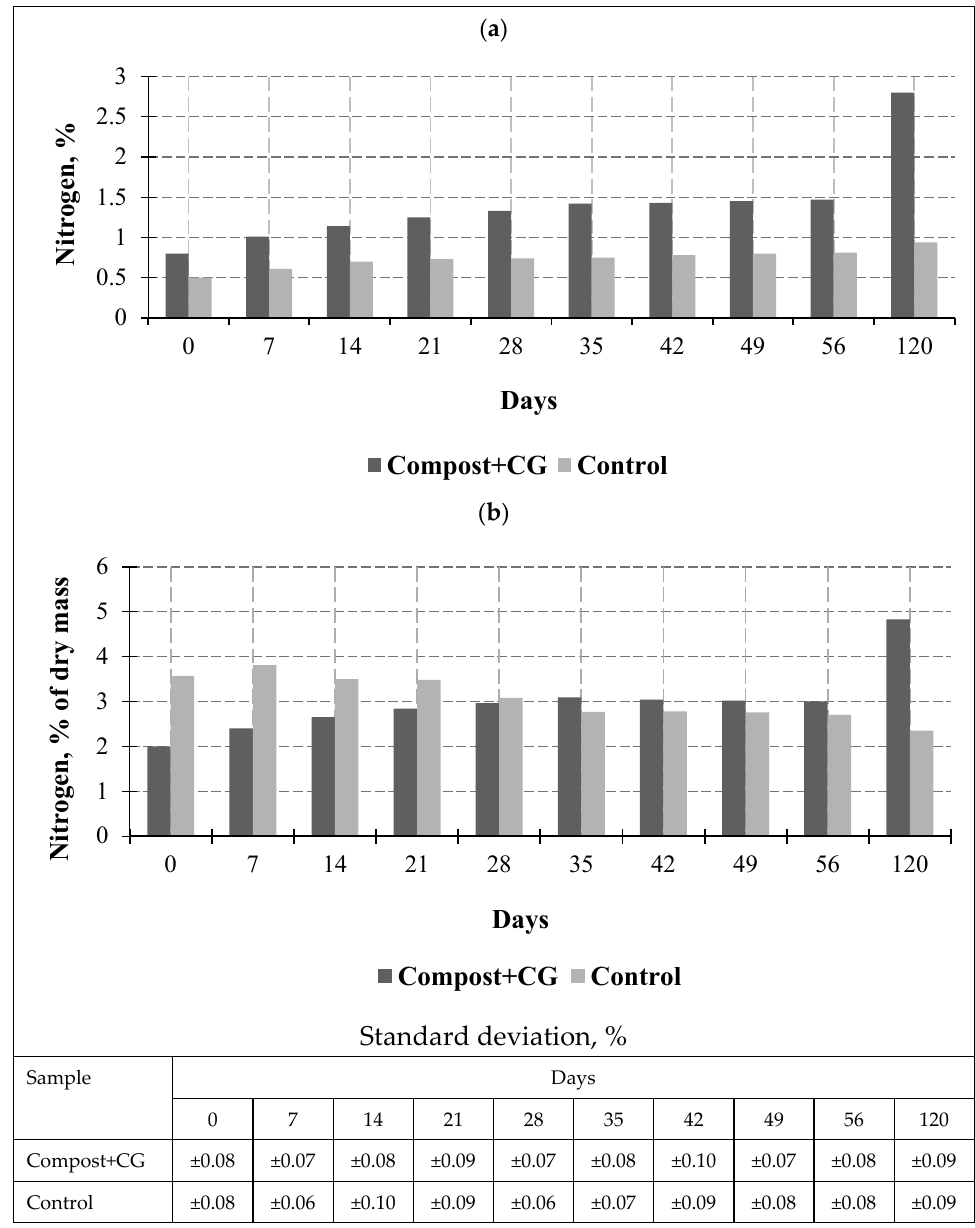
Figure 7. Change in nitrogen content during composting. ( a )—nitrogen content to original moisture; ( b )—nitrogen content in terms of dry mass.